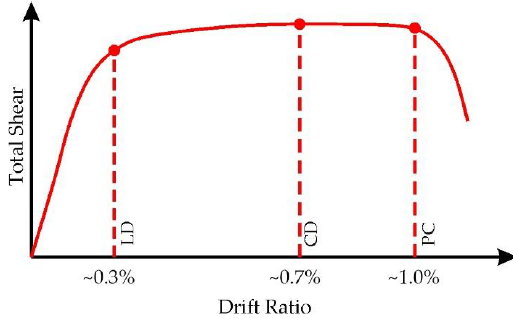
Figure 10. Pushover curve and limit states [42]. Table 1. Earthquake levels and performance targets [42].